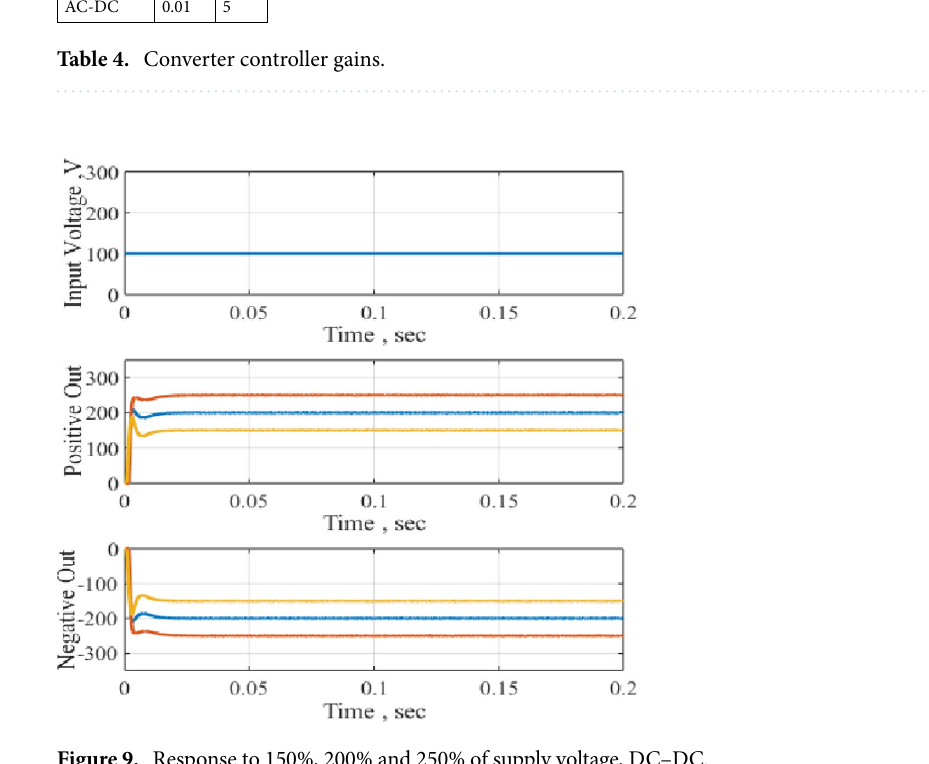
Figure 9. Response to 150%, 200% and 250% of supply voltage,